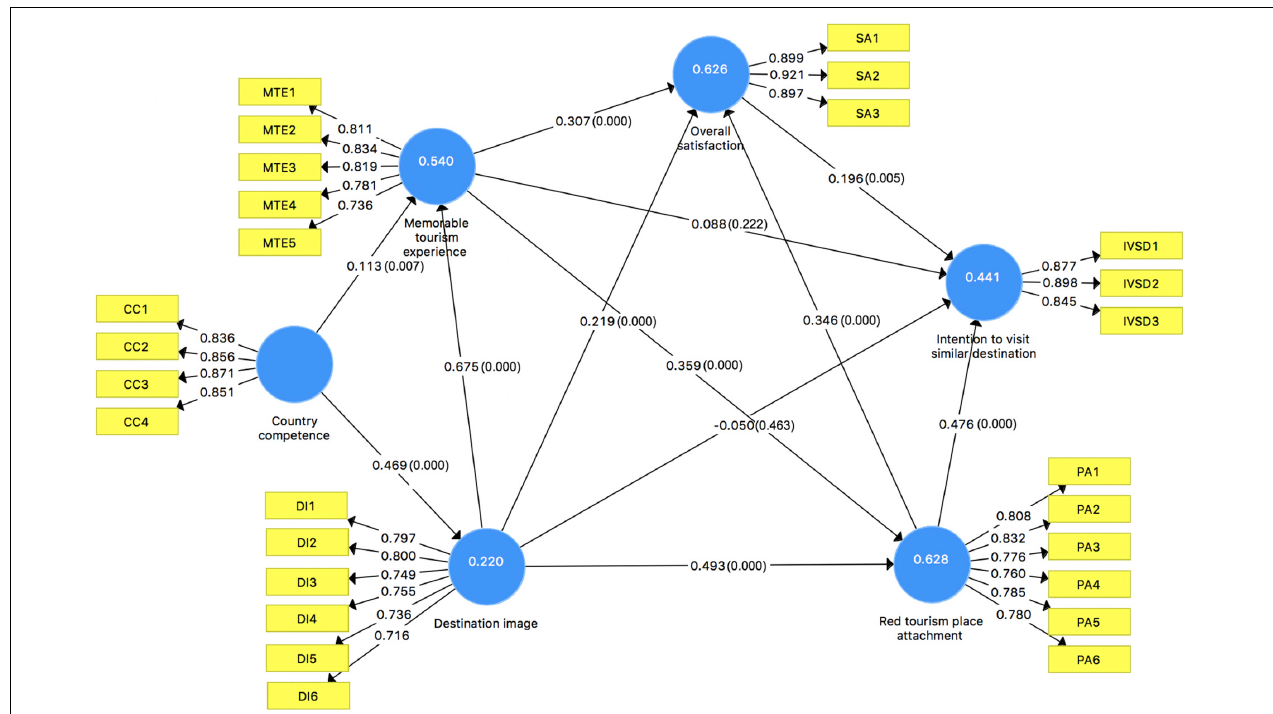
FIGURE 2 | Result of PLS-SEM analysis.